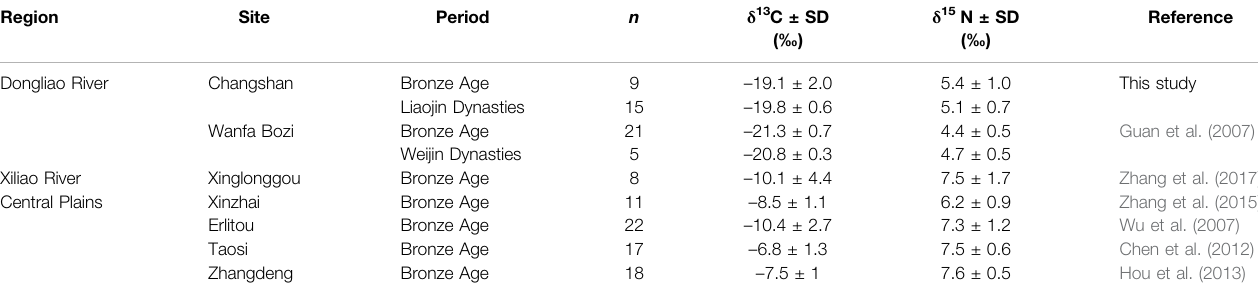
TABLE 2 | Summary of isotopic results for Pigs from the previous published data in different region, China. Region